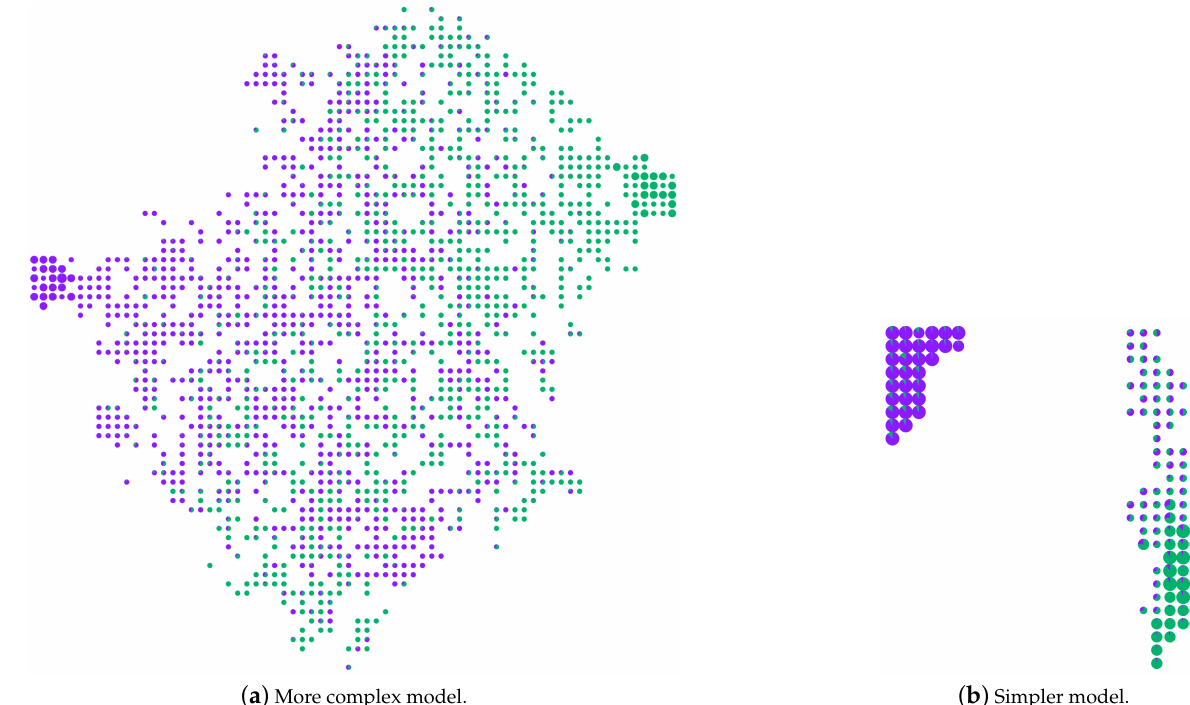
( a ) More complex model. ( b ) Simpler model. Figure 7. Comparative Analysis of the two RF models ( a ) Model 1 with 20 Trees, max_depth:7, Accuracy: 94.48%. ( b ) Model 2 with 30 Trees, max_depth:2, Accuracy: 94.3%. The visual comparison using RFMap shows the effectiveness of models from a variety of